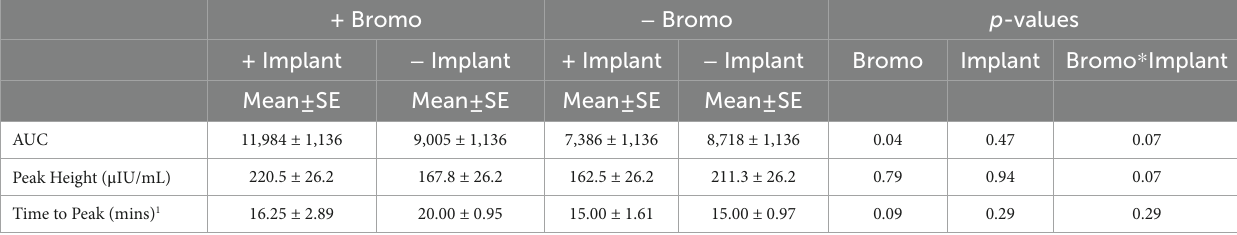
TABLE 5 Area under the curve, peak height, and time to peak of plasma insulin from steers treated with bromocriptine and estradiol/TBA implants before and following an IV glucose bolus. + Bromo − Bromo p -values + Implant − Implant + Implant − Implant Bromo Implant Bromo * Implant Mean ± SE Mean ± SE Mean ± SE Mean ± SE AUC 11,984 ±